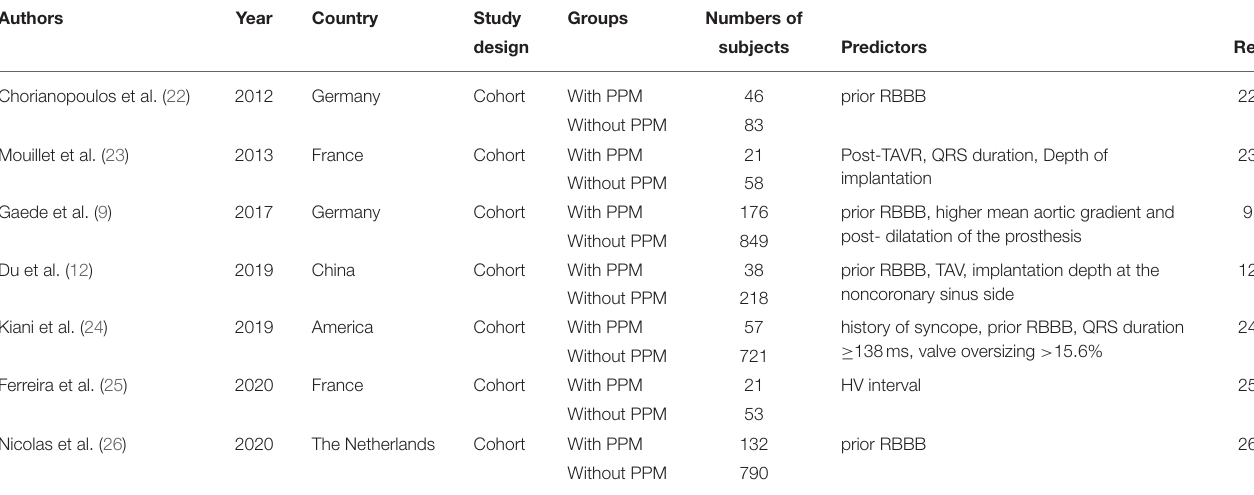
TABLE 4 | Summary of studies regarding predictors of Permanent Pacemaker Implantation after TAVR.